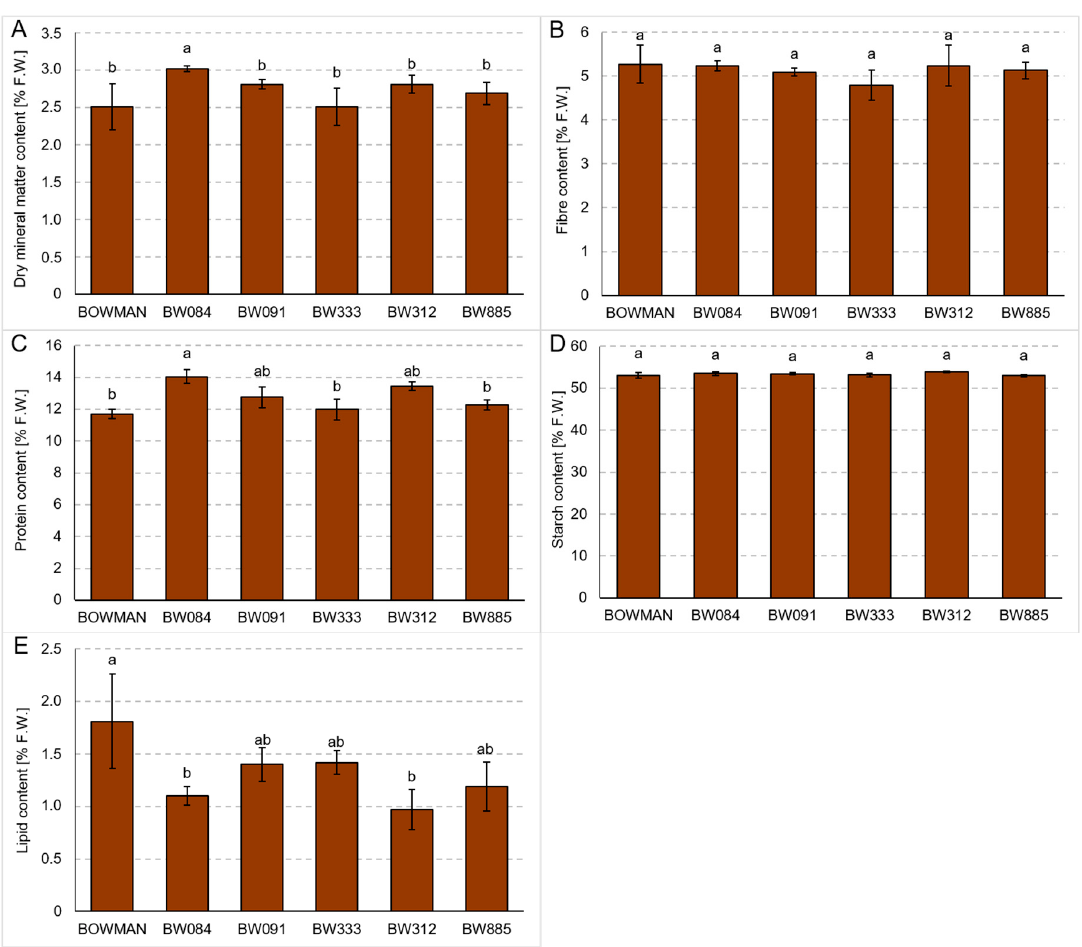
Figure 13. Chemical composition of grains produced under the field conditions: dry mineral matter content ( A ), fiber content ( B ), total protein content ( C ), starch content ( D ), and total lipid content ( E ). The mean values ± (SD) marked with the same letters are not significantly different, according to Duncan’s test ( p ≤ 0.05). Details are given in the text.